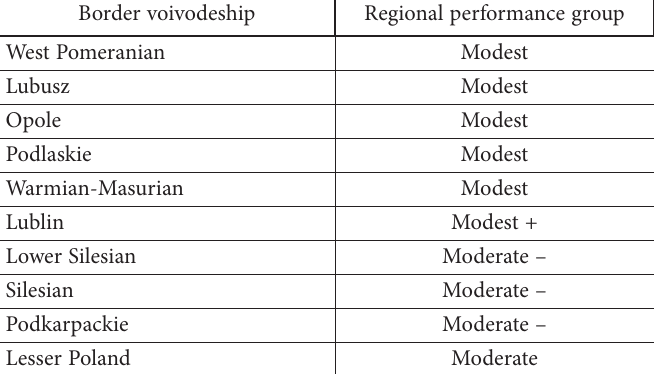
Table 2. Regional Innovation Scoreboard 2019 (source: created by authors according to data from Eu- ropean Commission and Maastricht University (Maastricht Economic and Social Research Institute on Innovation and Technology – MERIT, see Jokinen, 2020)) Border